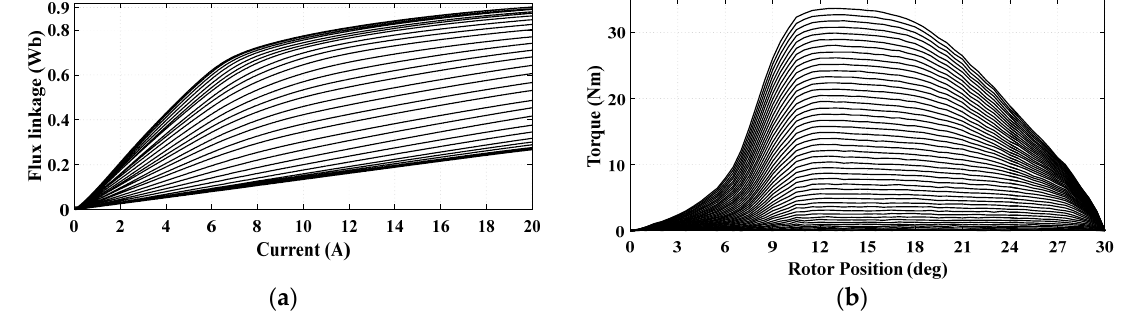
Figure 3. The measured data for: ( a ) the flux; ( b ) the torque. Table 1. The design data of the 8/6 switched reluctance motor (SRM) prototype in mm .